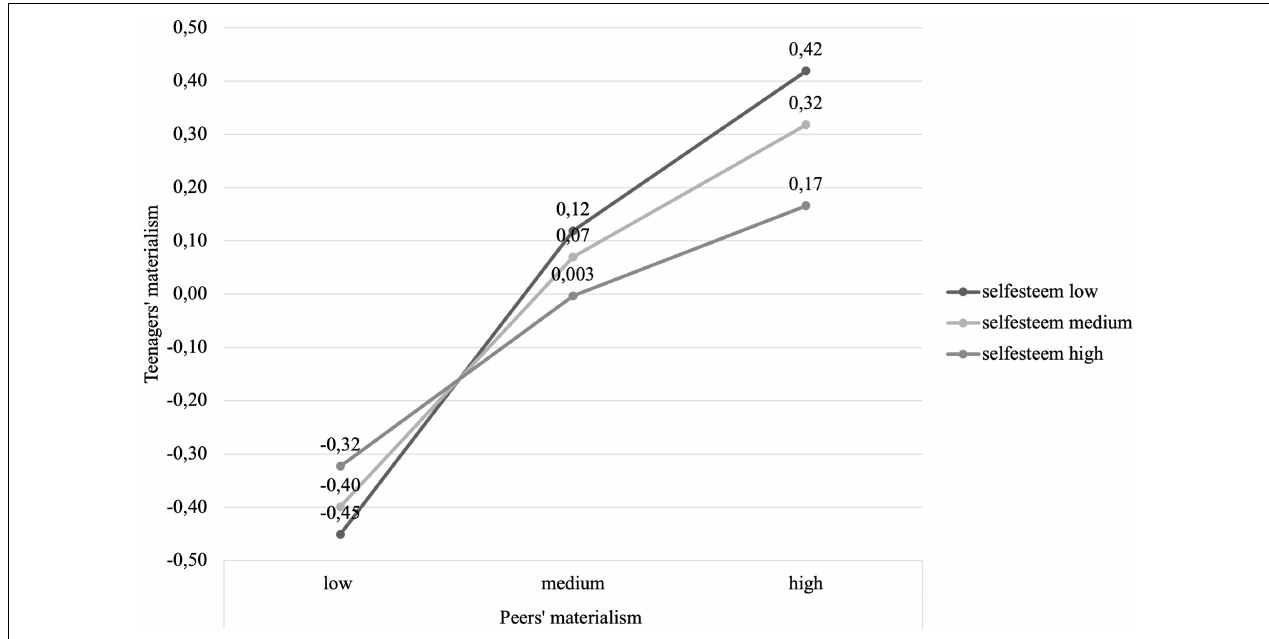
FIGURE 1 | Moderation effect of teenager self-esteem on the relationship between materialism of peer and materialism of teenager (Study